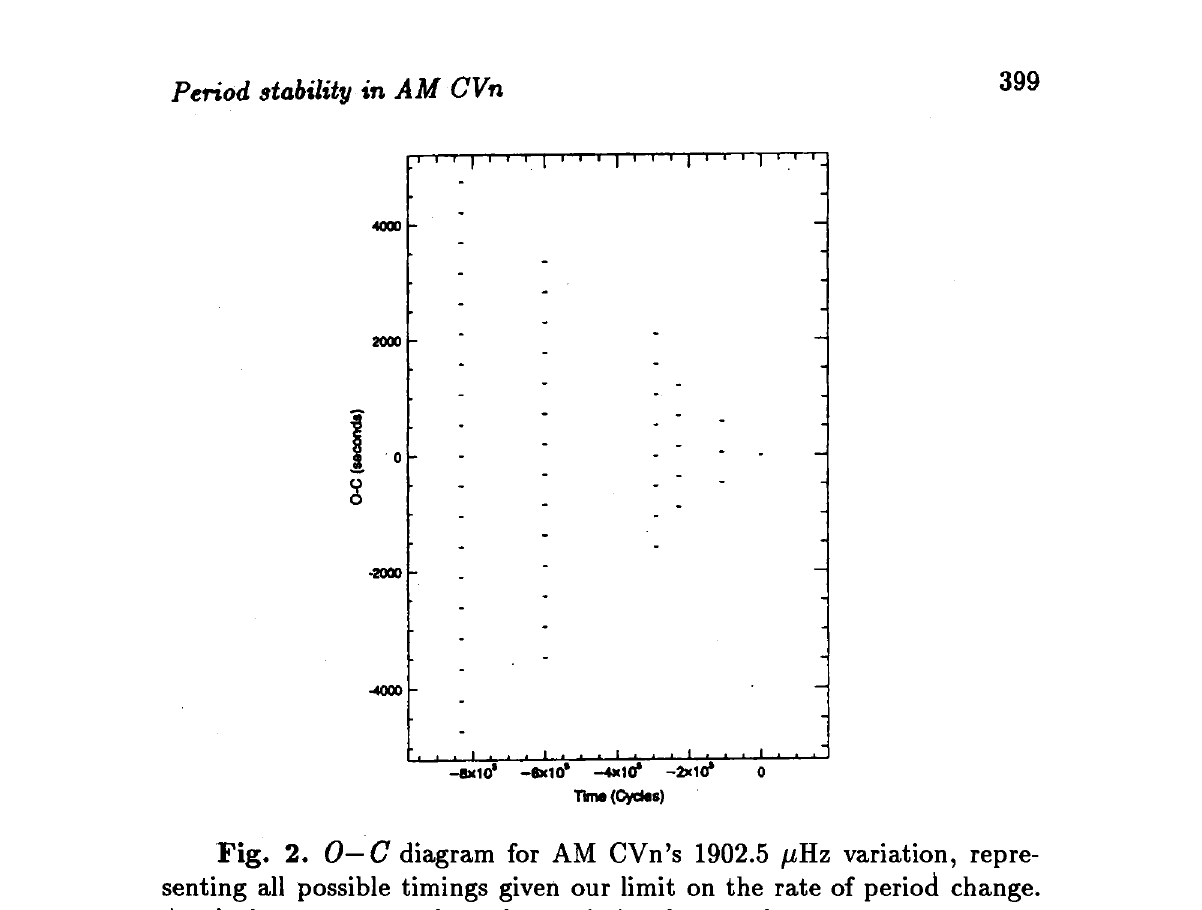
Fig. 2. 0—C diagram for AM CVn's 1902.5 ¿¿Hz variation, repre- senting all possible timings given our limit on the rate of period change. A solution must pass through one timing from each